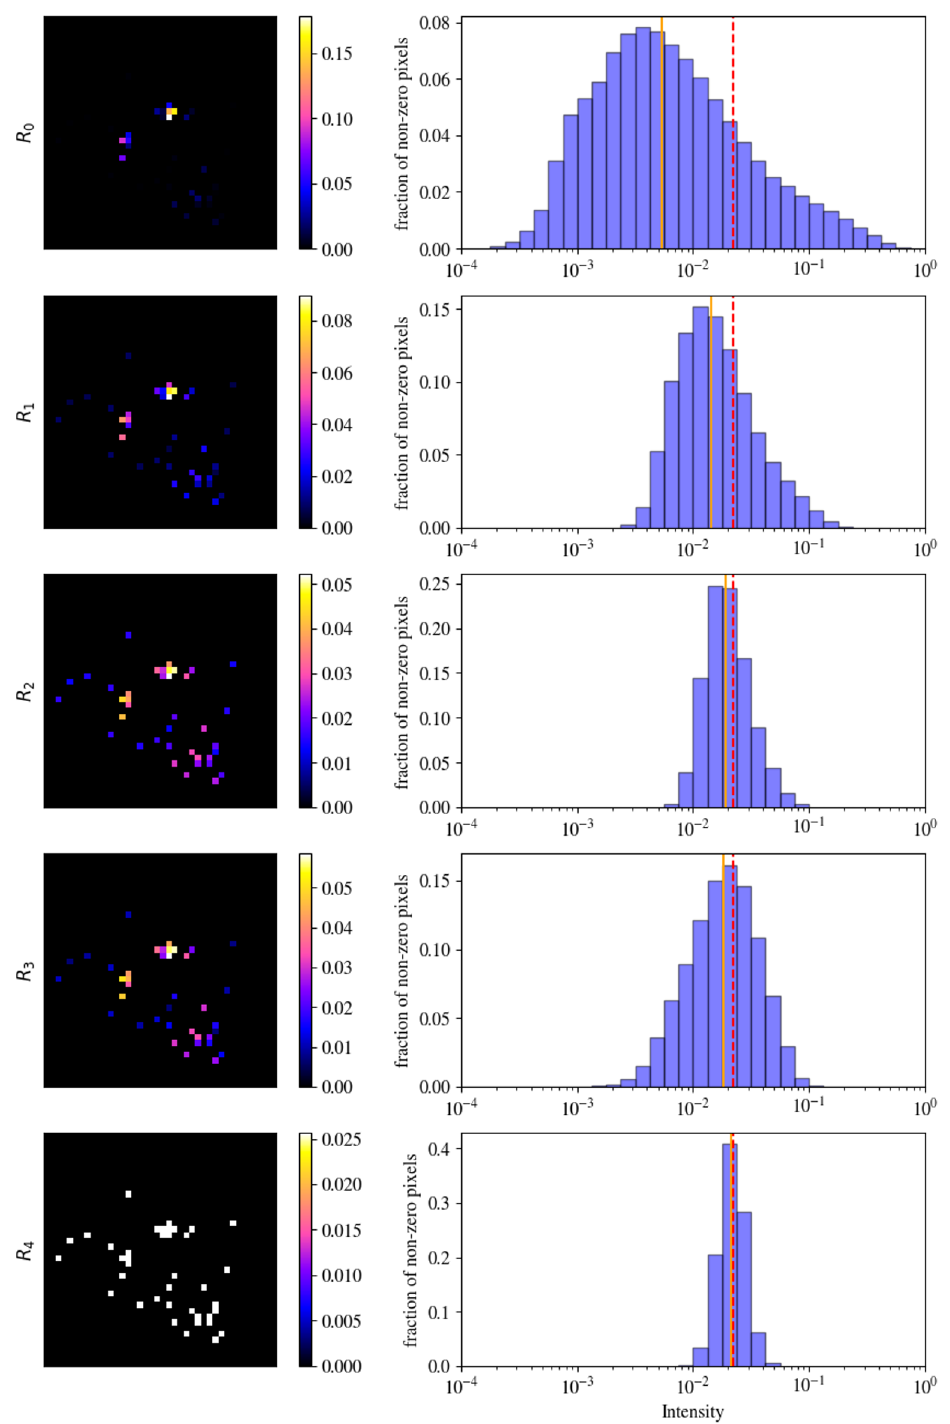
Figure 18 . Example of a top jet image (left), and the distribution of intensities of non-zero pixels for 100k top jet images (right) for different intensity remappings (from top to bottom R 0 , R 1 , R 2 , R 3 and R 4 ). The orange and red-dashed vertical lines are the median and the average of each distribution,